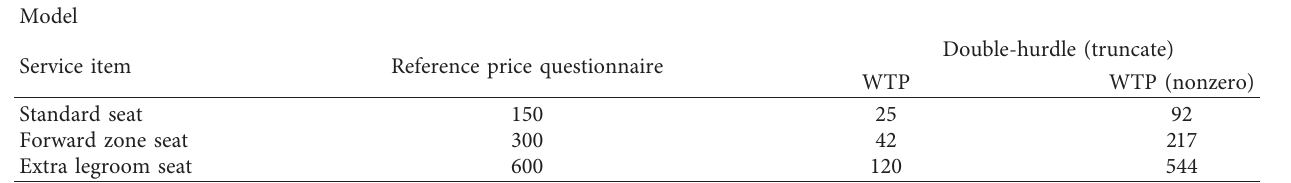
Table 11: The estimated results of WTP for different sizes of seat space (unit: